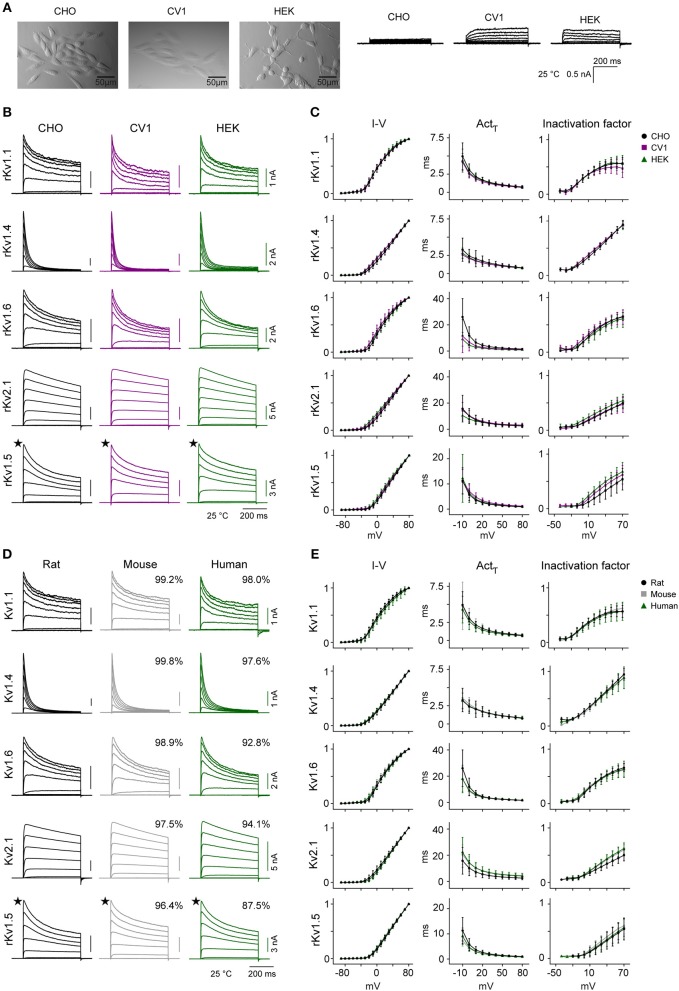
Kv channel kinetics across host cell lines and species at 25°C. (A–C) Comparison of Kv kinetics across three mammalian host cell lines. (A) Pictures showing the morphology of the three adherent host cell lines (CHO, HEK, and CV1) used in the study, with their corresponding endogenous outward currents in response to the activation protocol at 25°C. (B) Representative current traces from rat Kv1.1, Kv1.4, Kv1.6, Kv2.1, and Kv1.5 expressed in the three different cell lines, in response to activation protocol at 25°C. (C) Median values for three kinetic features (I-V curve, activation time constant, and inactivation factor calculated as explained in Figure 2) obtained from CHO, CV1, and HEK host cell lines for each Kv channel, overlaid for comparison. (D,E) Comparison of Kv kinetics across three species. (D) Representative current traces for rat, mouse, and human Kv1.1, Kv1.4, Kv1.6, Kv2.1, and Kv1.5 expressed in CHO cells, in response to activation protocol at 25°C. The percentage of homology compared to rat are shown in box above current traces (see also Table 4). (E) Median values for three kinetic features (I-V curve, activation time constant, and inactivation factor calculated as explained in Figure 2) obtained from rat, mouse, and human genes of each Kv channel, overlaid for comparison. Error bars are ± S.D. The amplitude in nA and time in ms are indicated with scale bars. ★: For Kv1.5, only one representative trace from a range of responses is shown. The number of cells (N) for each group is listed in Table S5.